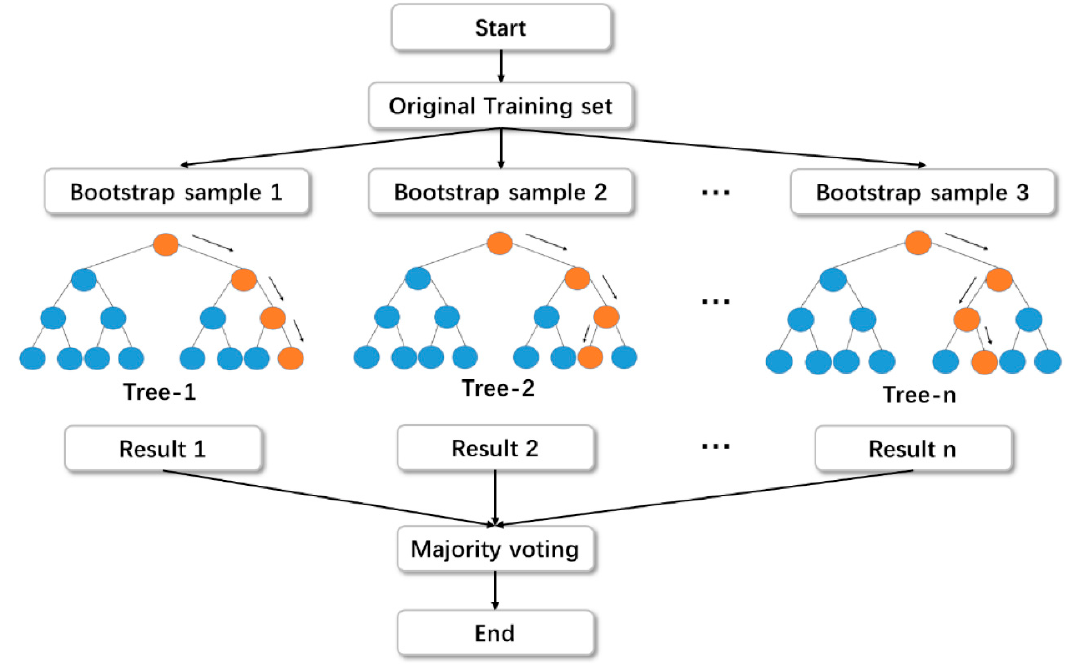
Figure 4. Structure of random forest-based modeling